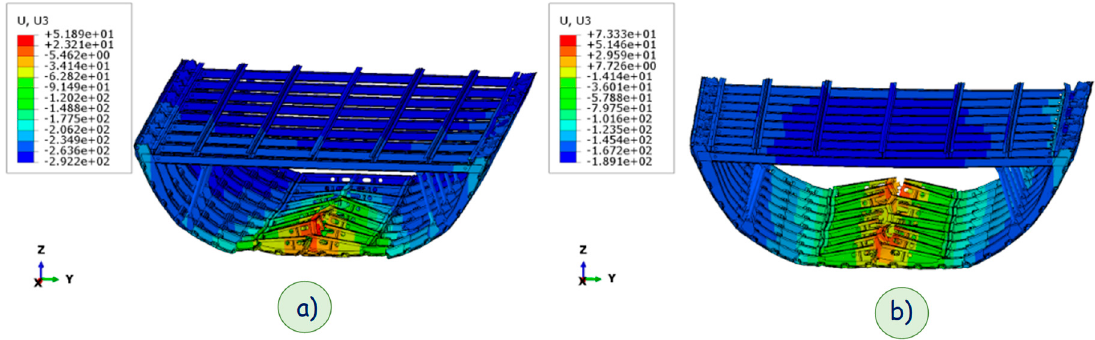
Figure 14. Sub cargo area: ( a ) Sloped impact; ( b ) normal impact (units in mm).